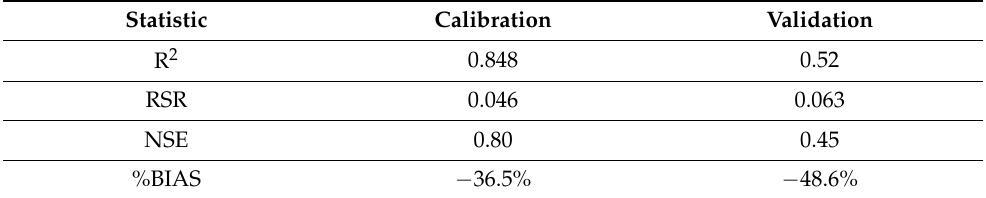
Figure 2. ( a ) Modeled and observed streamflow at the study area outfall for the calibration simulation, and ( b ) modeled and observed streamflow at the study area outfall for the validation simulation. All data are reported at 5 min intervals. Table 4. Performance statistics (coefficient of determination (R 2 ), Nash–Sutcliffe efficiency (NSE), root mean square error standard deviation ratio (RSR), and percent bias (%BIAS) for calibration and validation simulations of streamflow at the outfall for each 5 min time interval over the storm event.